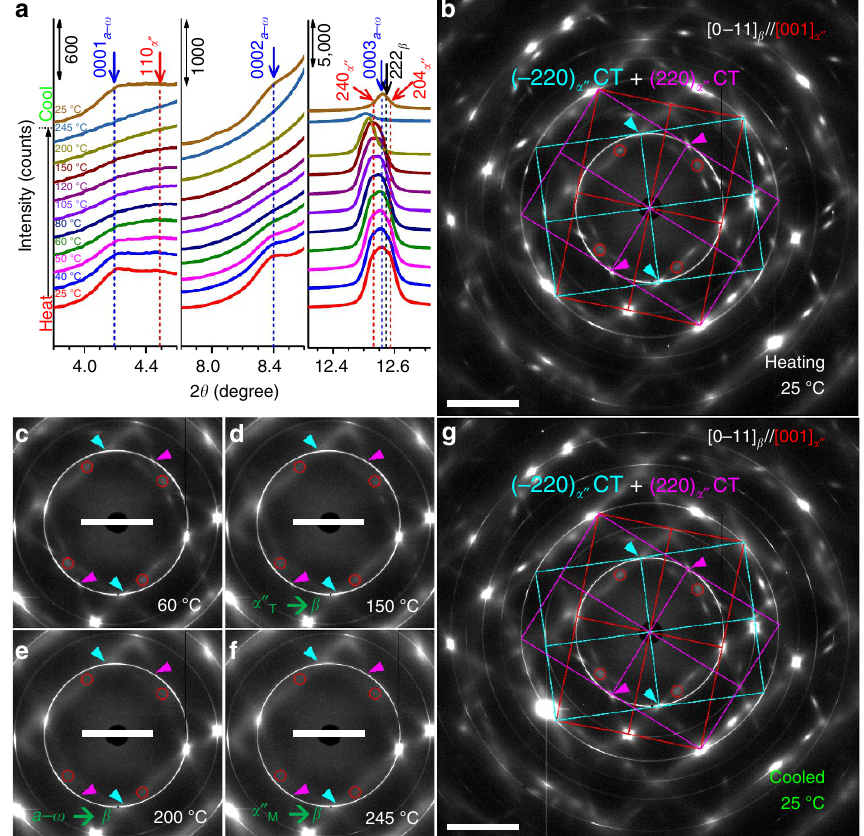
Figure 4 | Results of in-situ SXRD heating/cooling experiments. ( a ) Line profiles integrated from 2D SXRD patterns. ( b – g ) Representative 2D SXRD patterns at 25, 60, 150, 200, 245 (cid:2) C (during heating) and 25 (cid:2) C (after cooling), respectively. Scale bar, 5 (cid:2) .